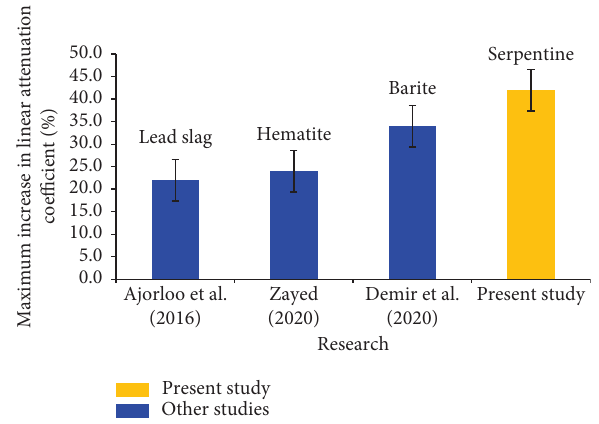
Figure 12: Comparison of the maximum LAC with other